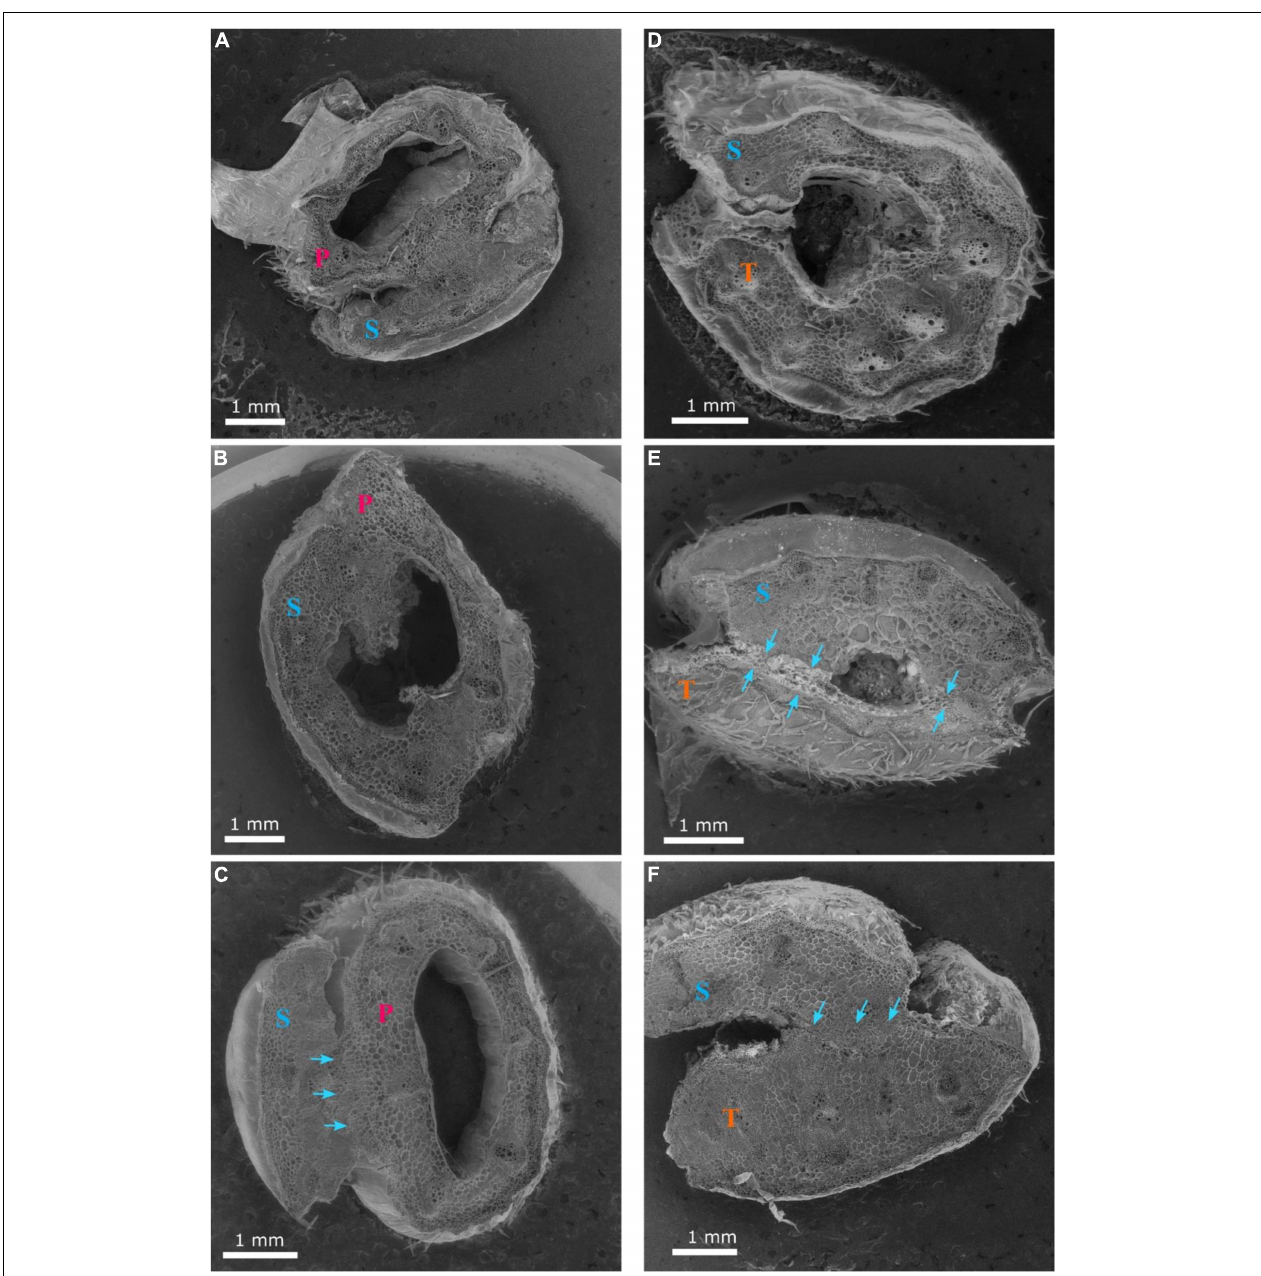
FIGURE 6 | Cross-sections 1 (A,D) , 2 (B,E) and 3 (C,F) of the graft union between watermelon cultivar ‘Secretariat’ (S) and rootstocks ‘Pelop’ (P; A–C ) and ‘Tetsukabuto’ (T; D–F ) at 25 days after grafting; where cross-sections were: (1) top of the graft union, (2) centered through the graft union, and (3) bottom of the graft union. The blue arrows (C,E,F) indicate the fully developed xylem vessels connecting the rootstock and scion at the graft